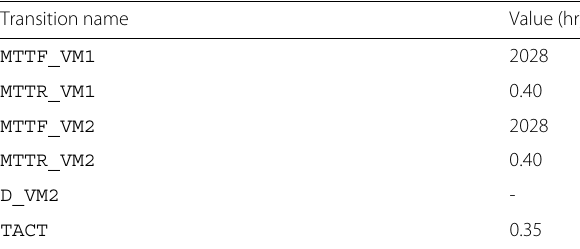
Table 4 Parameters for the cold-standby SPN